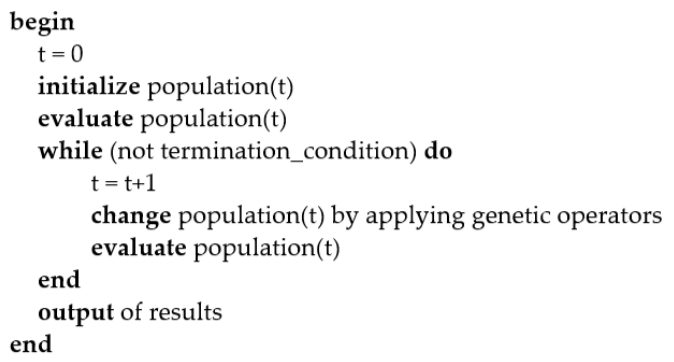
Figure 6. The pseudo code for genetic programming